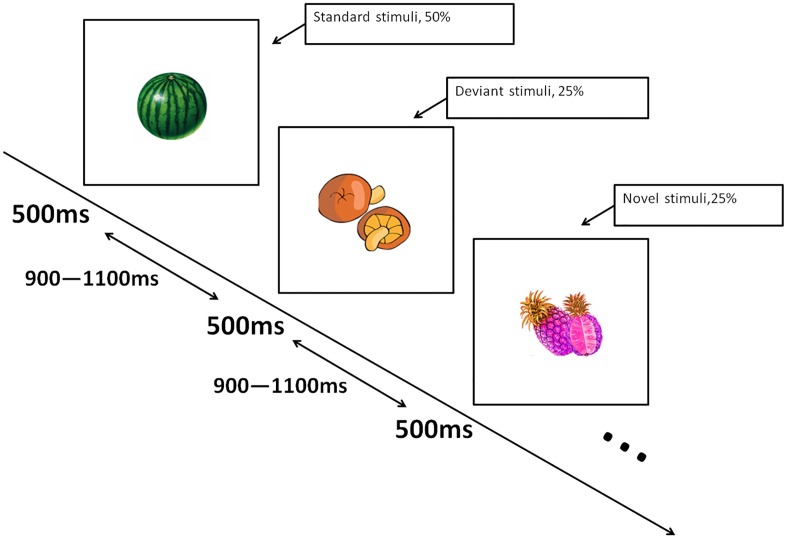
Three stimulus category simple visual Oddball task.There were 16 blocks with 50 trials per block. Participants were instructed to pay attention to all stimuli and to report the names of stimuli they had just viewed during breaks between blocks.